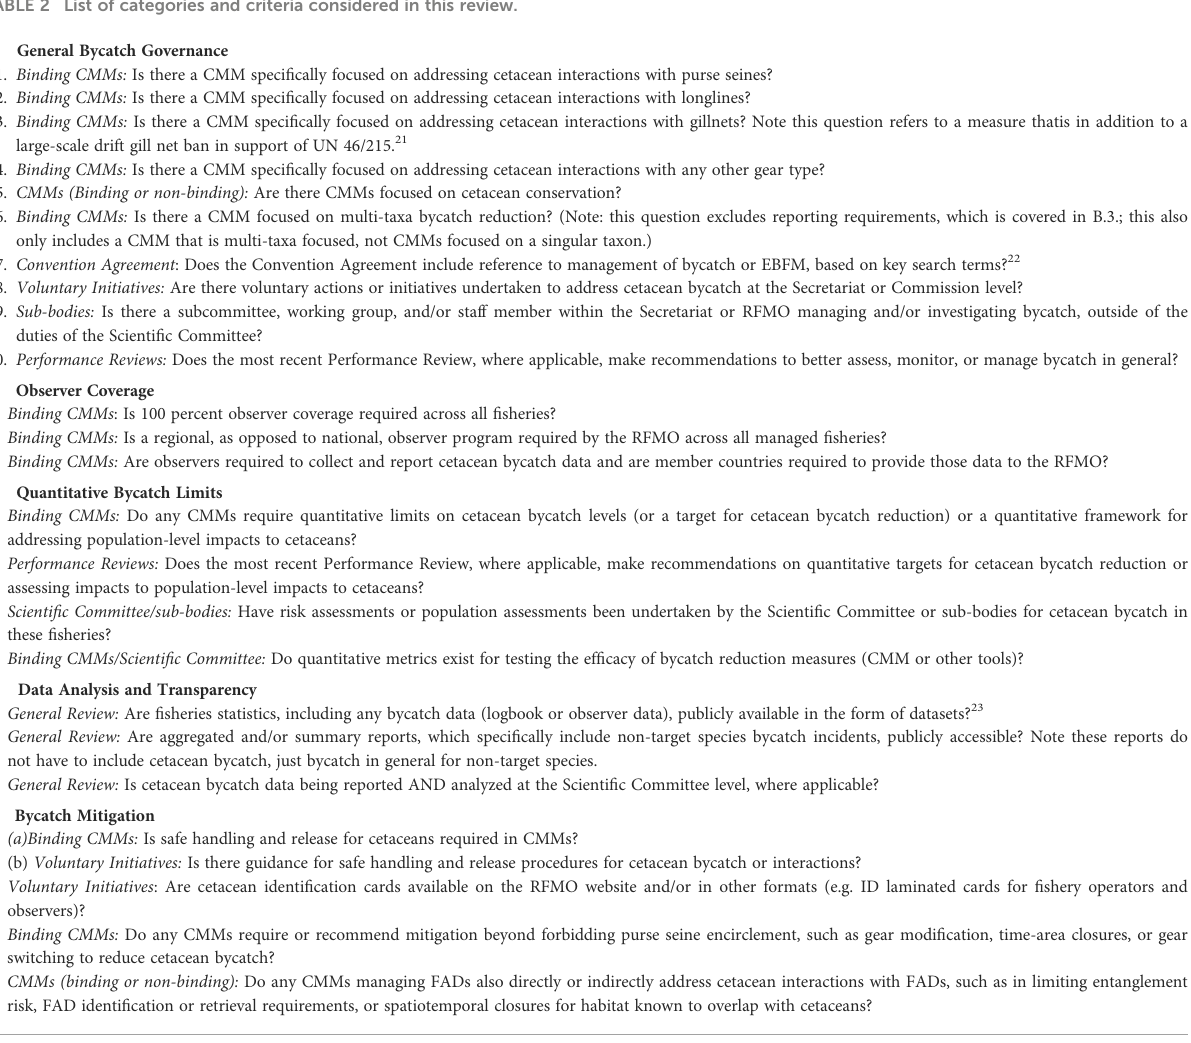
TABLE 2 List of categories and criteria considered in this